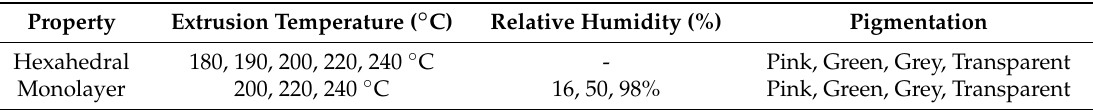
Table 2. Variables used in the manufacturing of hexahedron and monolayer